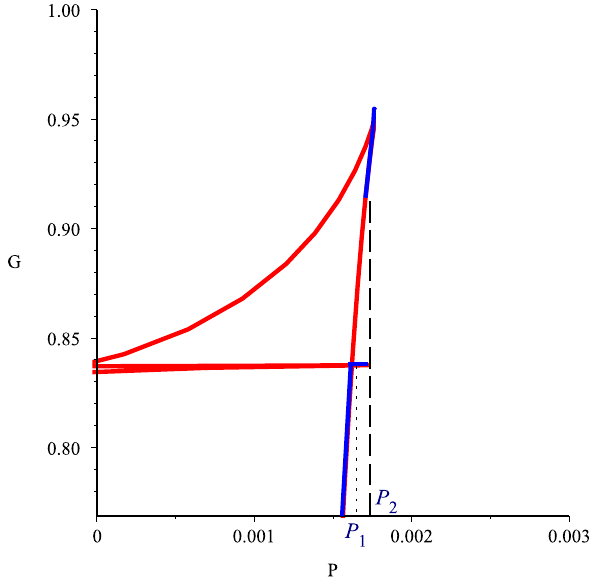
Fig. 11 Gibbs free energy for BID black holes versus pressure for T = 0 . 732 T c . Here we have fixed q = b = 1, α = 0 . 025, β = 0 .